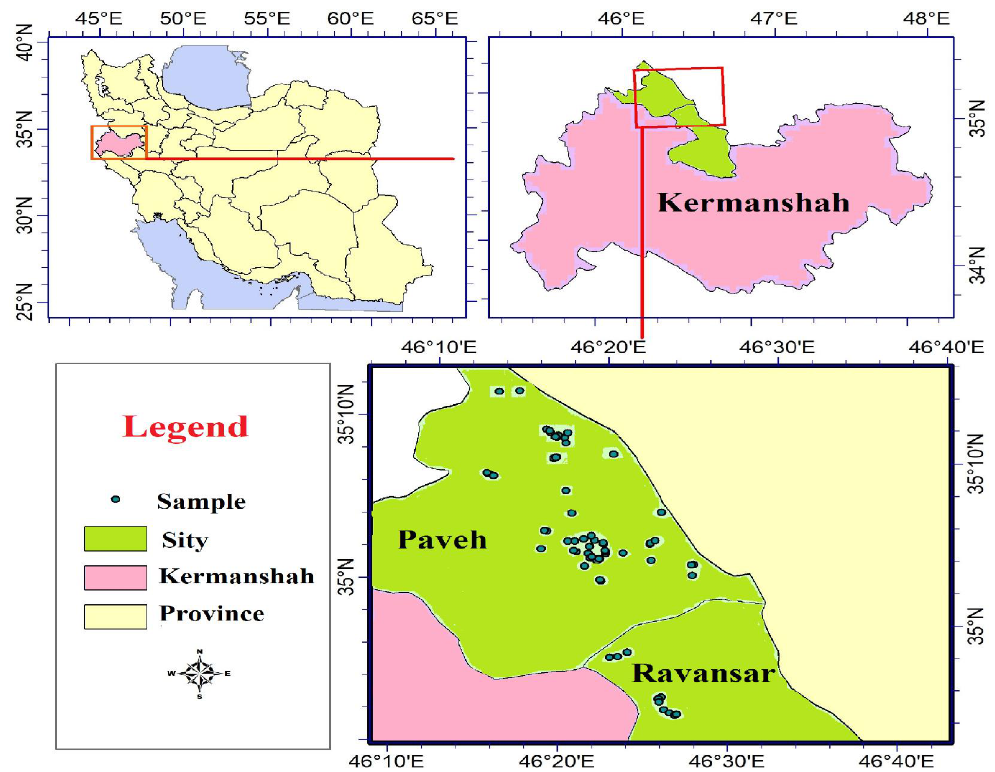
Fig. 1. Distribution map of the study